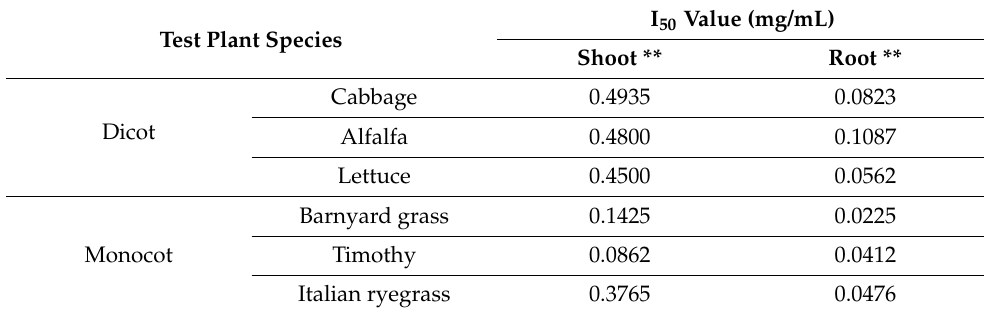
Figure 3. Inhibitory activity of the aqueous methanolic extracts of A. procera leaves against the growth of the tested species. The vertical bars on the treatments indicate mean ± SE with six replications ( n = 60). Significant variations between the control and different treatments are represented by different letters (according to Tukey’s HSD test at the 0.05 level of probability). Table 1. I 50 values of the aqueous methanolic extracts of A. procera leaves against the different test species.